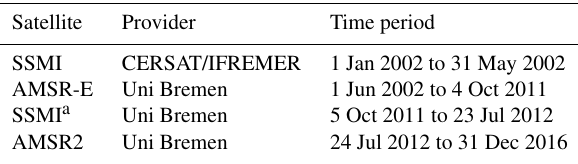
Table 3. Overview of sea ice concentration data used in CCLM. Download for CERSAT/IFREMER athttp://cersat.ifremer.fr/data/ (last access: 31 March 2020) and for Uni Bremen at